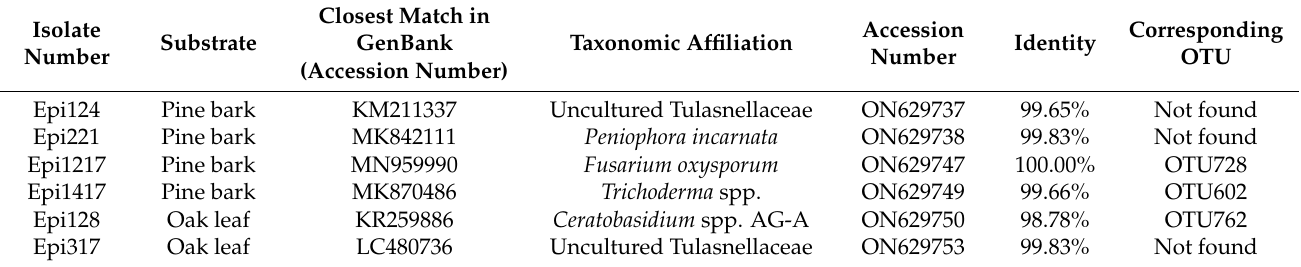
Table 1. Molecular identification of fungi isolated from ex situ symbiotically germinated